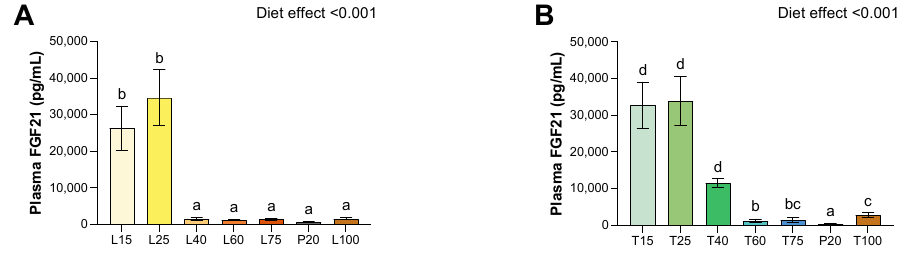
Figure 3. Effect of lysine or threonine deficiency on plasma FGF-21 levels. ( A ) Plasma FGF-21 levels for lysine diets. ( B ) Plasma FGF-21 levels for threonine diets. Values are expressed as means + SEM. Data that do not share the same letter are different at p < 0.05.